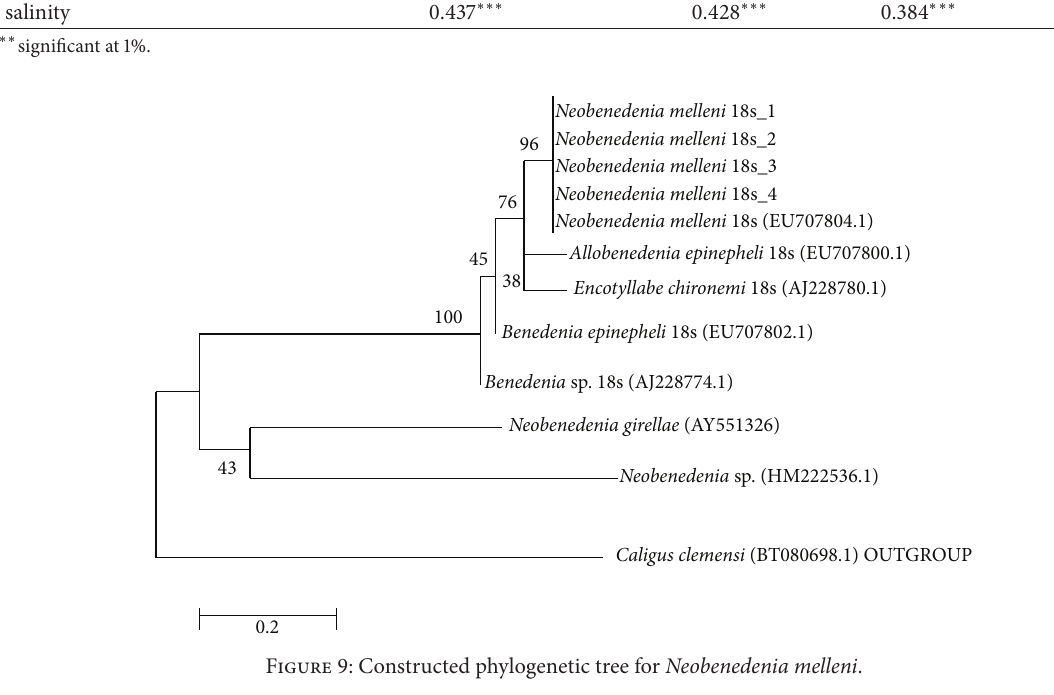
Figure 9: Constructed phylogenetic tree for Neobenedenia melleni .